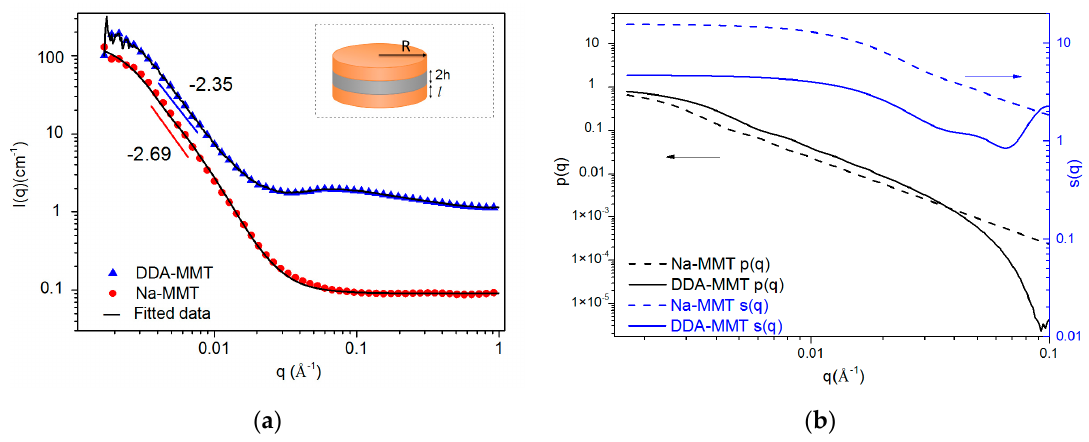
Figure 4. ( a ) SANS intensity profiles and fitted lines from 0.5 wt% dispersion of Na-MMT in D 2 O and DDA-MMT in ethanol according to a sandwich structure model (inset) and ( b ) the separate form and structure